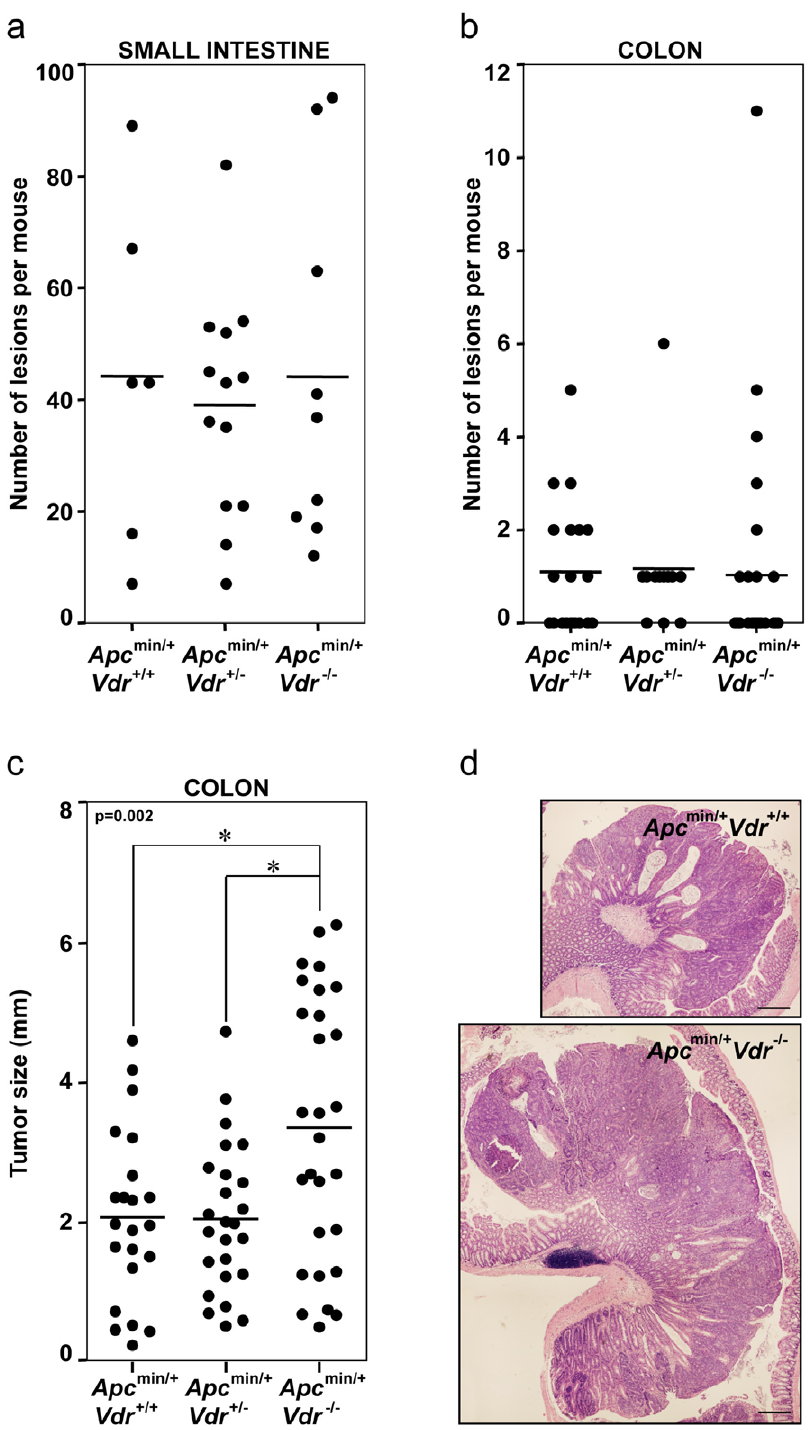
Figure 1. Vdr deficiency increases tumor load but not tumor number in Apc min/ + mice. Total number of tumors (adenomas and carcinomas) in the small intestine (a) or in the colon (b) of Apc min/ + Vdr + / + , Apc min/ + Vdr + / 2 and Apc min/ + Vdr -/- mice. Each dot corresponds to one mouse analyzed and the horizontal line indicates the mean. (c) Size of colon tumors (adenomas and carcinomas) from Apc min/ + Vdr + / + , Apc min/ + Vdr + /- and Apc min/ + Vdr -/- mice. Each dot corresponds to one tumor analyzed and the horizontal line indicates the mean. The p-value for one-way ANOVA analysis is shown. Asterisks indicate significant differences between groups upon Bonferroni multiple comparison post-test. (d) Representative hematoxylin/eosin staining images of colon carcinomas from Apc min/ + Vdr + / + and Apc min/ + Vdr -/- mice. Scale bar, 300 m m.